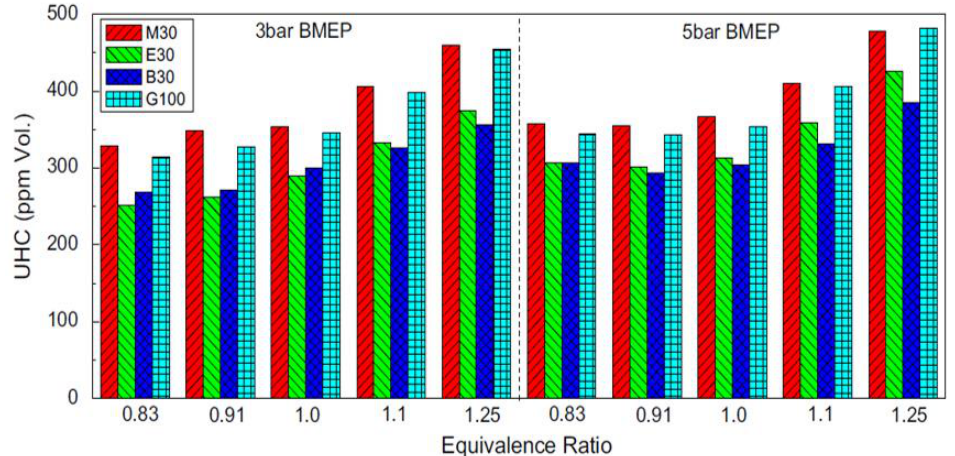
Figure 10. Variation in HC emissions with equivalence ratio, engine load and test fuel: comparison between gasoline (G100), 30% methanol v/v (M30), 30% ethanol v/v (E30) and 30% butanol v/v (B30) [95]. Reproduced with permission from Applied Thermal Engineering; published by Elsevier, 2017. License Number: 5094081168292. Table 2. Main experimental tests concerning the effect of ethanol concentration and operating con- ditions on HC and CO emissions using gasoline/ethanol blends in SI engines.